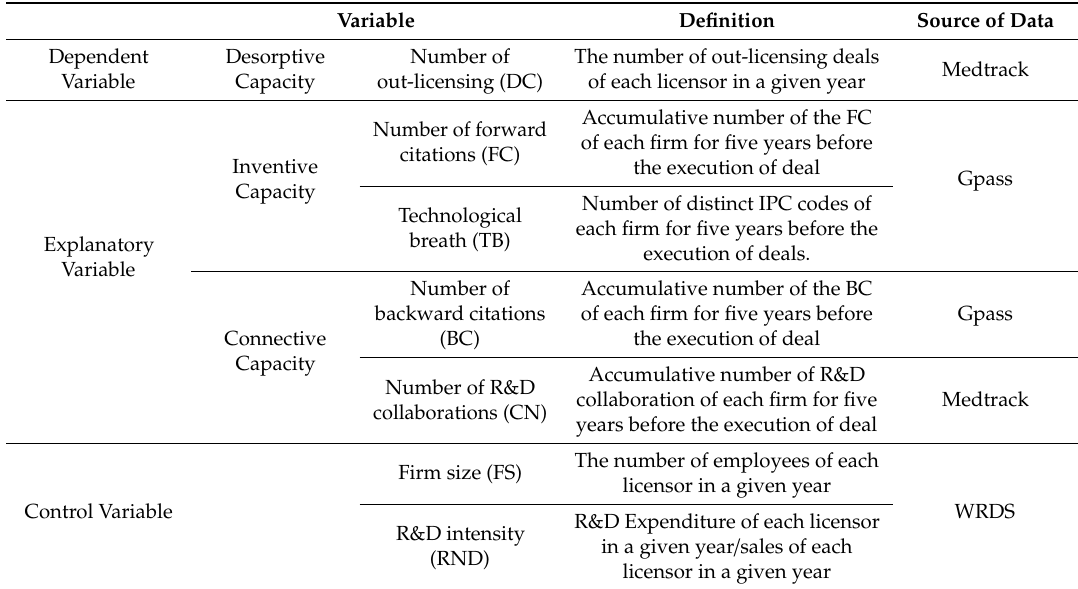
Table 2. Specification of